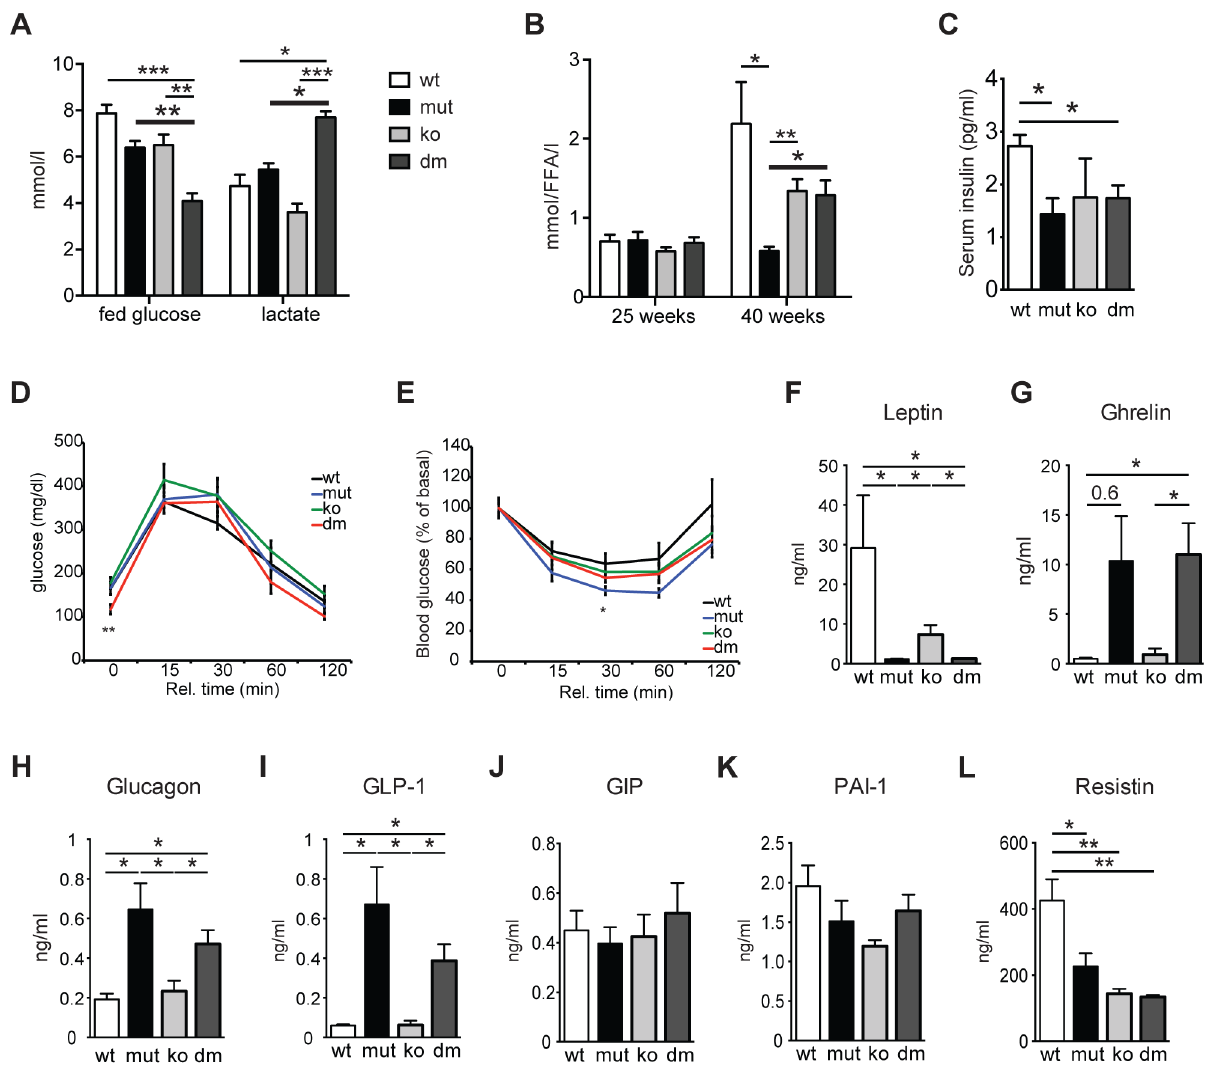
Figure 2. Characterization of blood metabolites in wild type (wt), mtDNA mutator (mut), UCP2-deficient wild type (ko) and mtDNA mutator (dm) mice. (A) Blood glucose and lactate concentrations at 25 weeks of age. (n=6). (B) Circulating free fatty acid levels in 25- and 40-week- old animals. (n=5–6). (C) Serum insulin levels of 30-week-old mice. (D) Glucose tolerance test in 30-week-old mice. After 16 hours of starvation period, mice were injected with 2g/kg body weight glucose and clearance was measured after 0, 15, 30, 60 and 120 minutes (n=7). (E) Insulin tolerance test of 30-week-old random fed mice. Mice were injected with 0.75 U/kg body weight of insulin and glucose levels were measured after 0, 15, 30 60 and 120 minutes (n=7). (F–L) Analyses of metabolic markers in the serum: (F) Leptin; (G) Ghrelin; (H) Glucagon; (I) Glucagon-like peptide 1 (GLP-1); (J) Glucose-dependent insulinotropic polypeptide (GIP); (K) Plasminogen activator inhibitor-1 (PAI-1); (L) Resistin. All measurements were performed in 30-week-old mice. (n=4). Bars indicate mean levels 6 standard error of the mean (S.E.M.). Statistically significant differences between mut and dm are presented with thick lines. Asterisks indicate level of statistical significance (*p , 0.05; **p , 0.005; ***p , 0.001, Student’s t -test).